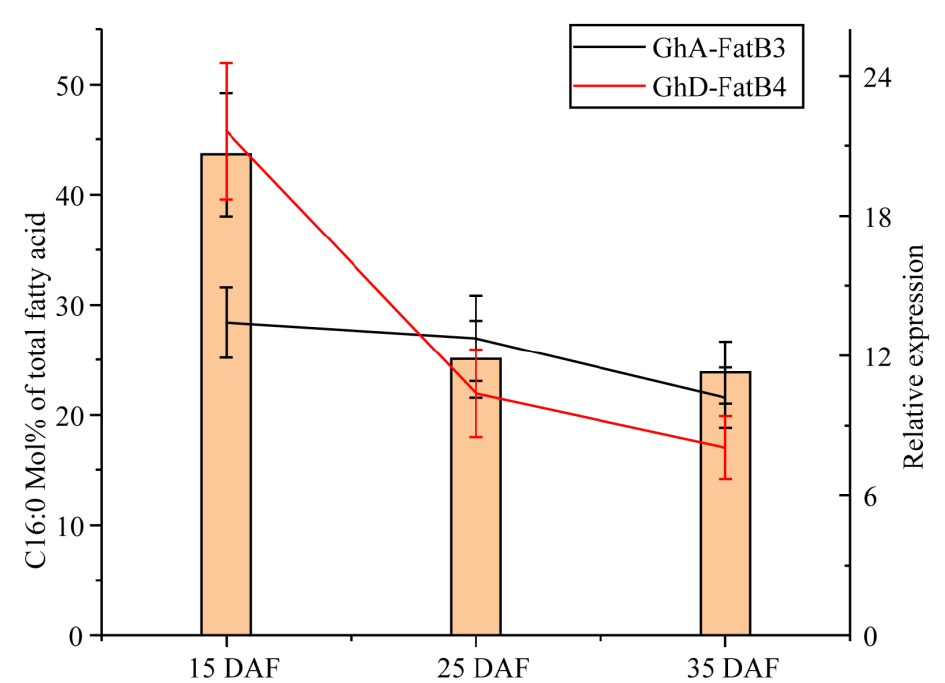
Figure 6. The correlation of the expression of GhA-FatB3 and GhD-FatB4 with molar percentage of C16:0 in the developing cotton seeds. The columns show the C16:0 content (mol% of total fatty acids) and lines for the relative expressions of the target genes (Black for GhA-FatB3 , Red for GhD-FatB4 ). Six biological replicates were analyzed for all samples.